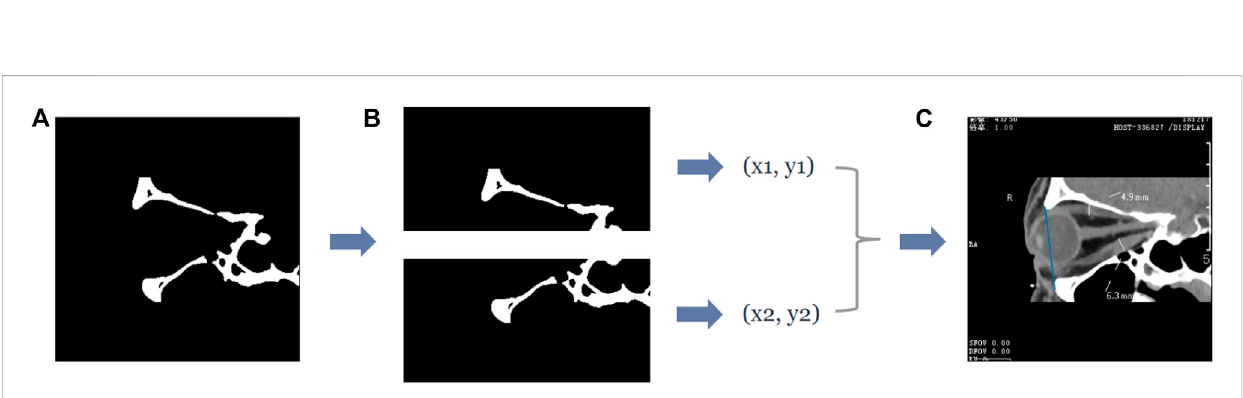
FIGURE 5 The process of obtaining the coordinates of the most protruding points of the upper and lower orbital rim in the sagittal plane of the CT image. (A) The second row of Figure 4B, which is the binary image containing the upper and lower orbital rim regions, and extracts the submaps of the upper and lower halves, respectively, to obtain the two submaps as shown in (B) . Subsequently, the coordinates of the most protruding points of the superior and inferior orbital rims can be determined by traversing the two subgraphs separately, and then the straight line passing through the two most protruding points can be obtained — the straight line is shown in blue in (C)